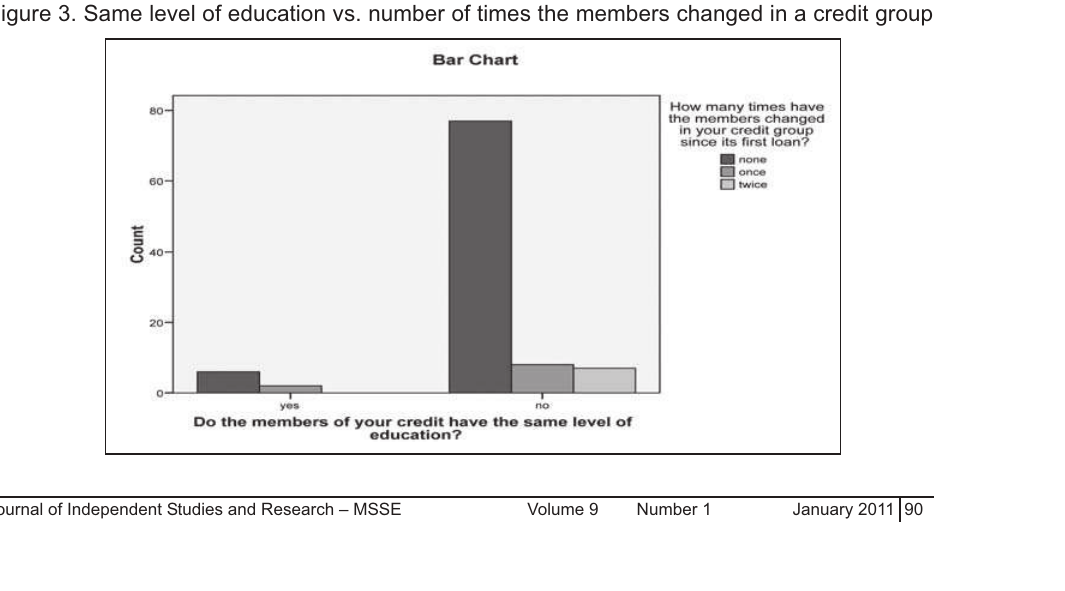
Figure 3. Same level of education vs. number of times the members changed in a credit